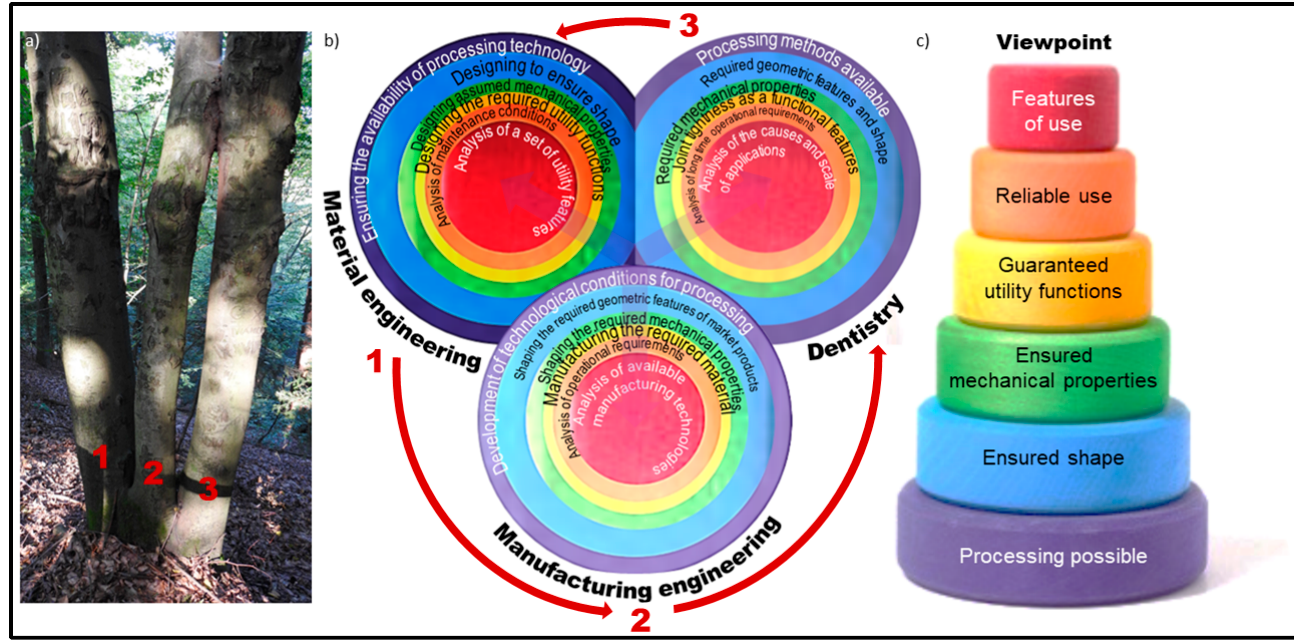
Figure 2. An example of beech with a triangularly branched trunk in Roztocze National Park in Poland ( a ) with synergy diagrams of materials engineering, manufacturing engineering, and dentistry ( b ) and a hierarchical arrangement of the main analyzed issues concerning filling materials used in endodontics ( c ).